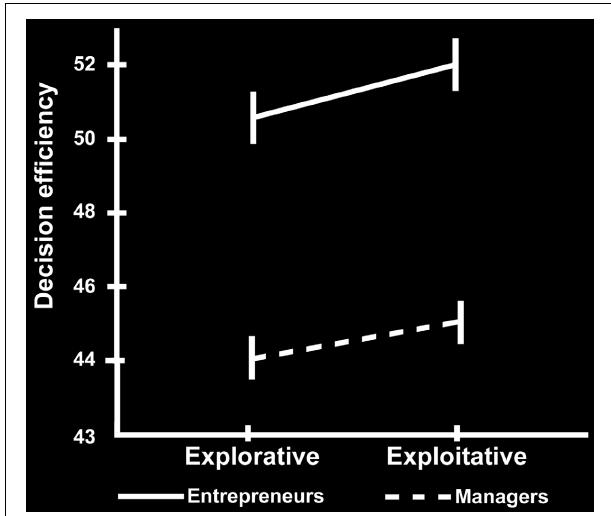
FIGURE 2 | Behavioral results. Decision-making efficiency in explorative and exploitative choices for the group of managers (dotted line) and entrepreneurs (simple line). The vertical bars reflect the standard